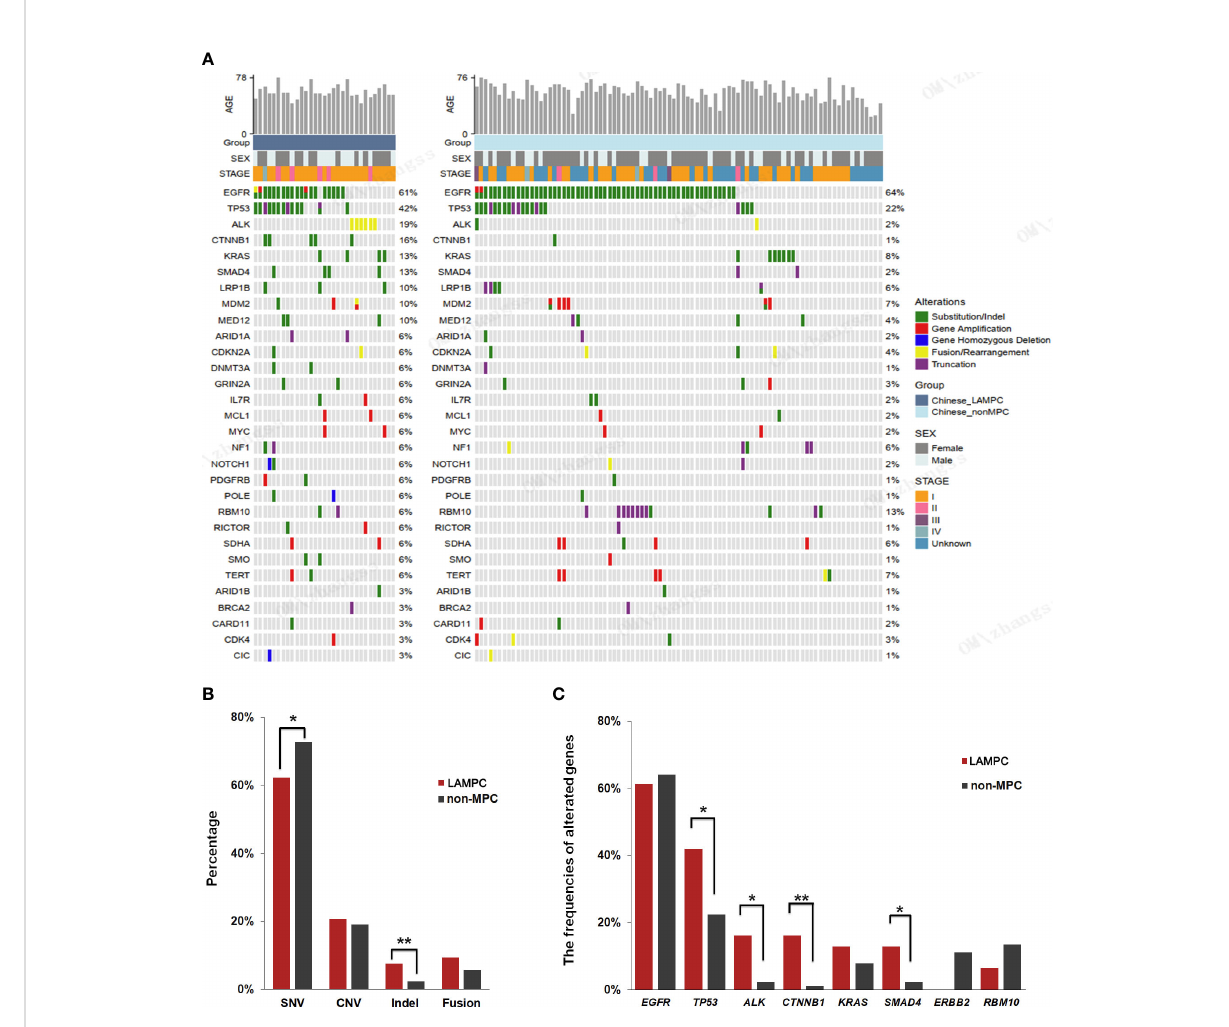
FIGURE 2 A comparison of genomic alterations between LAMPC and non-MPC patients. (A) A genomic alteration pro fi le of 31 LAMPC samples from 29 patients and 89 non-MPC patients. (B) A comparison of mutation types between the two groups. (C) A comparison of major driver gene mutations between LAMPC and non-MPC groups. * p < 0.05, ** p <